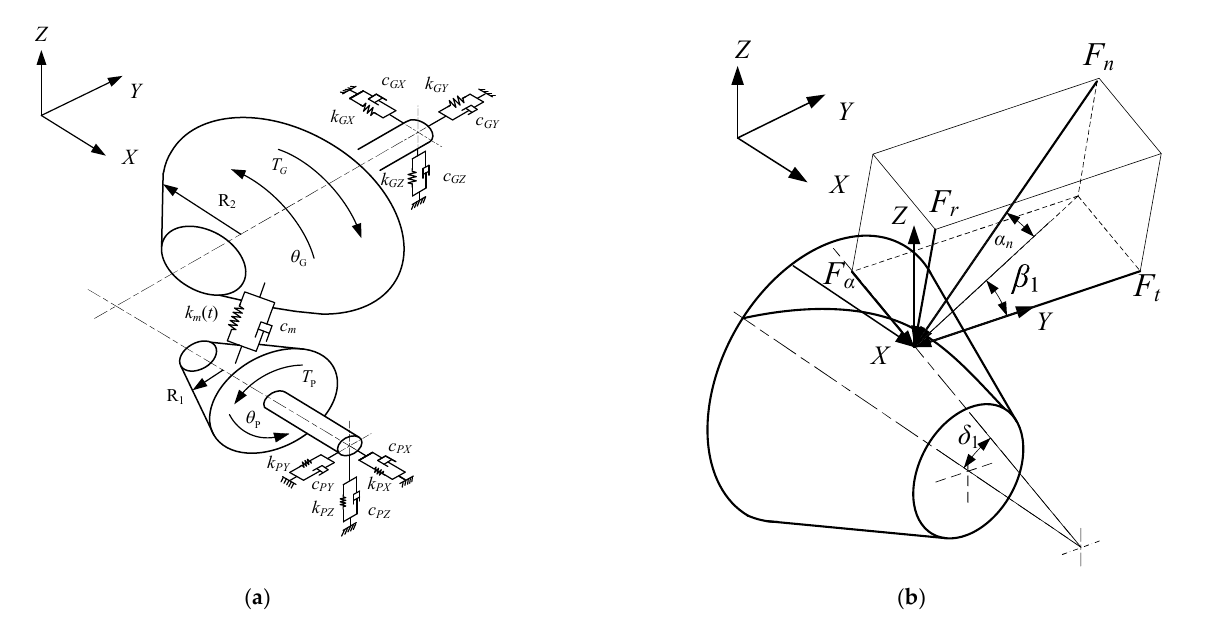
Figure 5. Analysis of the main reducer: ( a ) coupled vibration model of the main reducer; ( b ) force analysis of pinion.